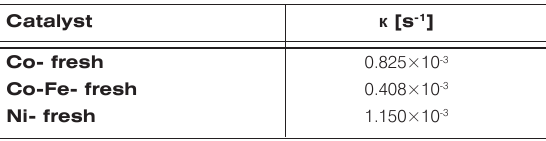
Table 2. First-order rate constants of catalytic decomposition of NaOCl over the investigated catalytic samples Catalyst